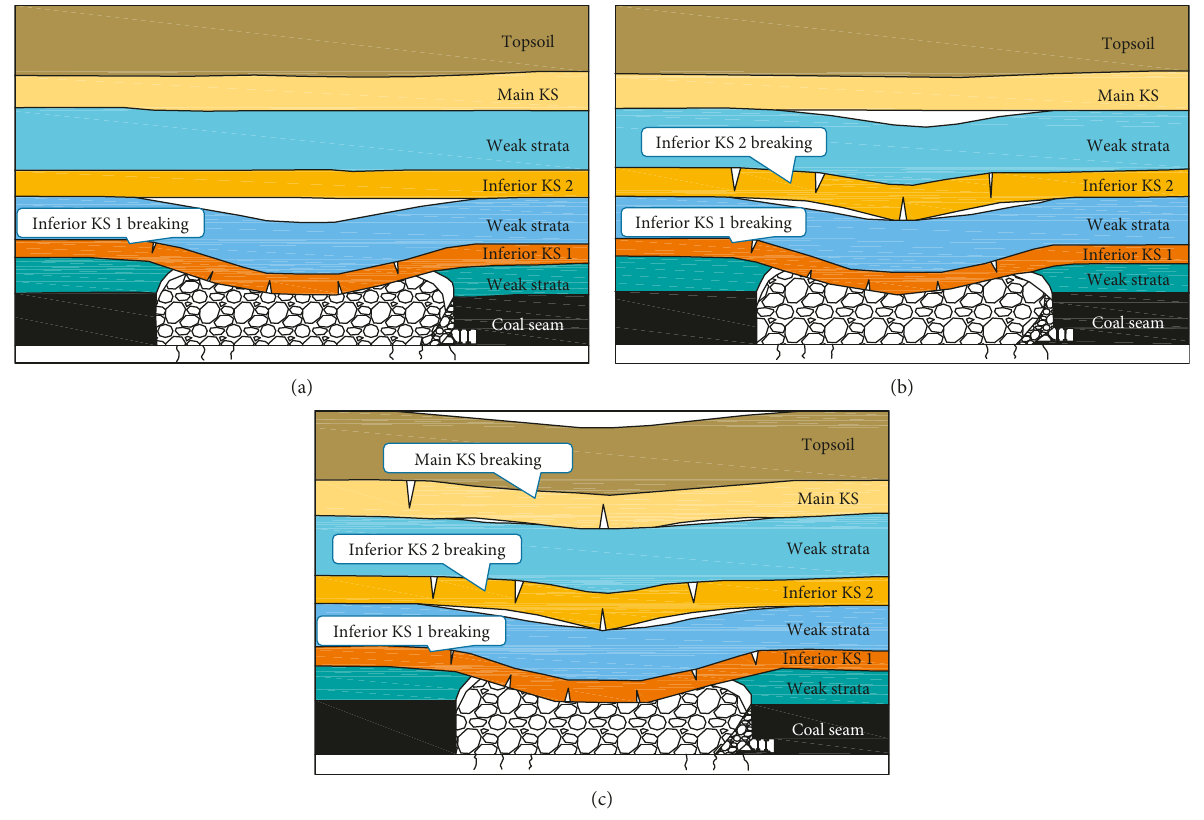
Figure 3: Dynamic process of the overlying rock movement. The breakage of inferior (a) KS 1, (b) KS 2, and (c) main